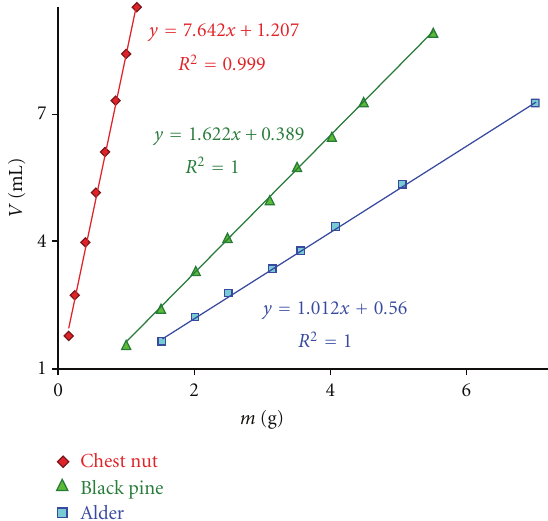
Figure 4: Graphical evaluation of consumed alkali of titration in dependence on sample